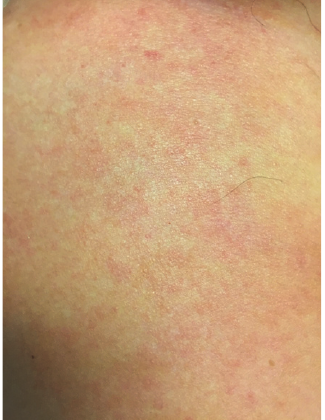
Figure 4: Maculopapular rash noted on admission on the patient’s